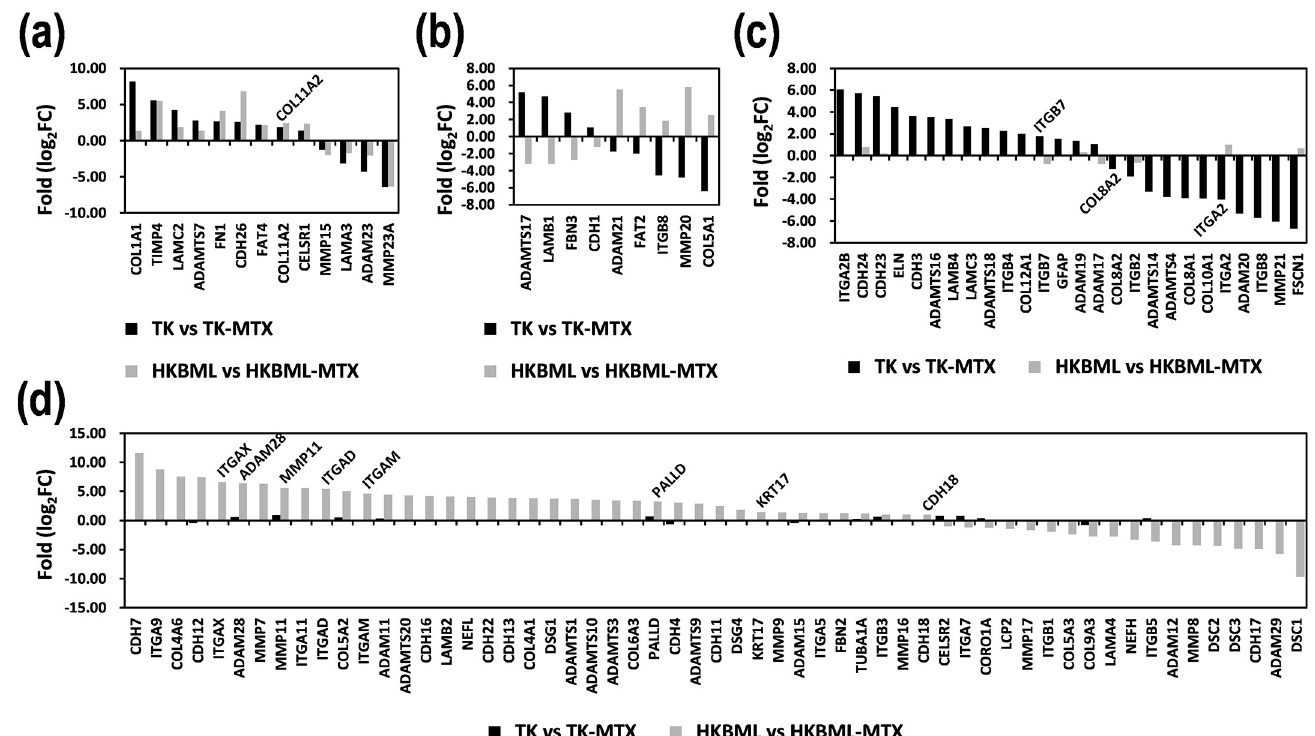
Fig 6. Expression patterns of the genes associated with cell morphology and microenvironment in MTX-resistant PCNSL cells. ( a ) Similar pattern of the differential expression in TK-MTX and HKBML-MTX compared with the control cells. ( b ) Reciprocal pattern of the differential expression in TK-MTX and HKBML-MTX compared with the control cells. ( c-d ) Cell-type specific differential expression in ( c ) TK-MTX and ( d ) HKBML-MTX. Gene expression was verified with NGS. DEGs in MTX-resistant PCNSL cells compared with control PCNSL cells were designated by |log 2 FC| > 1. The gene symbols highlighted into graphs contributed to prognosis prediction formulas and Kaplan-Meier survival estimation (see S5 Table). DEG; differential expression gene, FC; fold change, TK-MTX; MTX-resistant TK, HKBML-MTX; MTX-resistant HKBML.